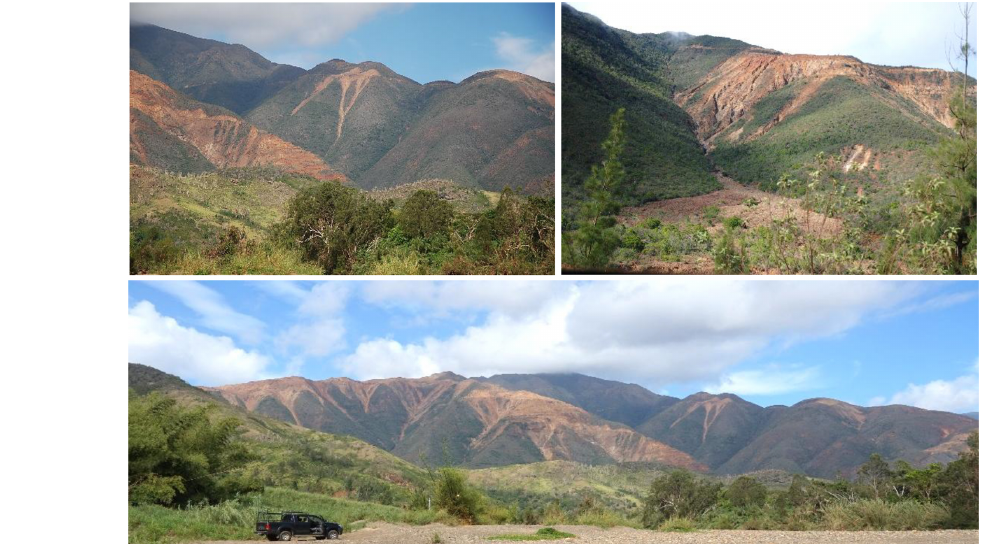
Figure 3. Photographs of concentrated erosion and mass movement processes observed on peridotite massifs of the Thio River catchment.